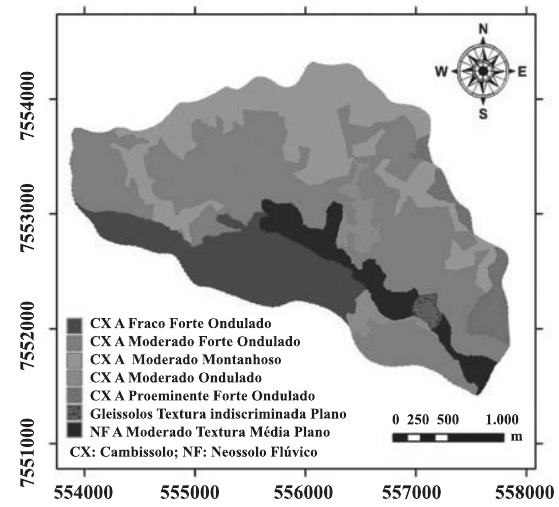
Figura 1. Distribuição espacial dos solos na bacia hidrográfica experimental do ribeirão Lavrinha, Serra da Mantiqueira, Minas Gerais (Adaptado de Menezes et al.,